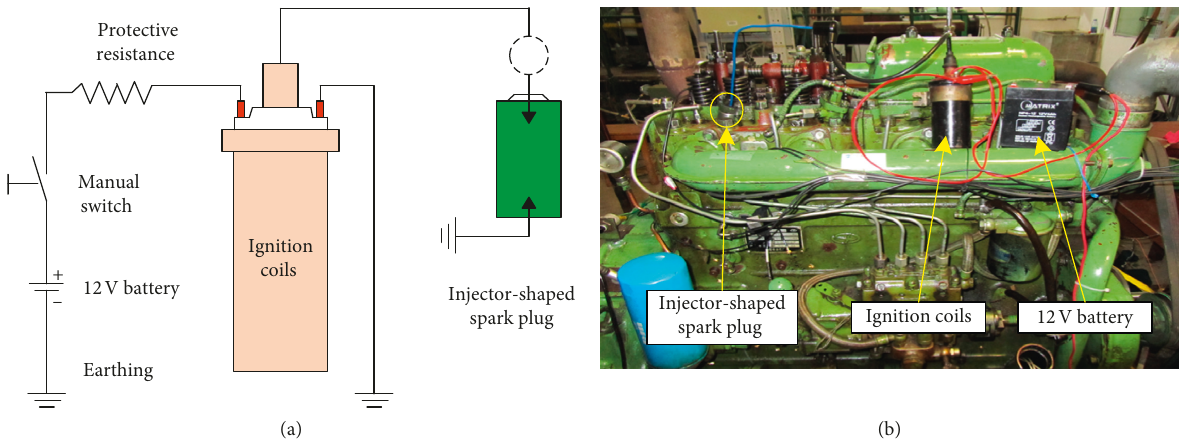
Figure 3: Self-designed ignition system device. (a) Ignition system structure diagram and (b) ignition system physical